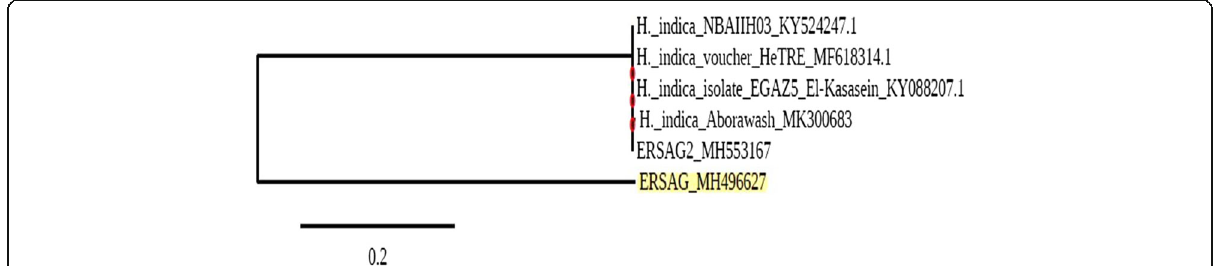
Fig. 1 Maximum likelihood ITS phylogenetic trees of Heterorhabditis indica species using ITS sequence. Based on nucleotide sequences of H. indica (ERSAG, H. indica Aborawash, and ERSAG2) and reference strains (alignment length approximately 700 bp using phylo_tree analysis (phylogeny.fr.